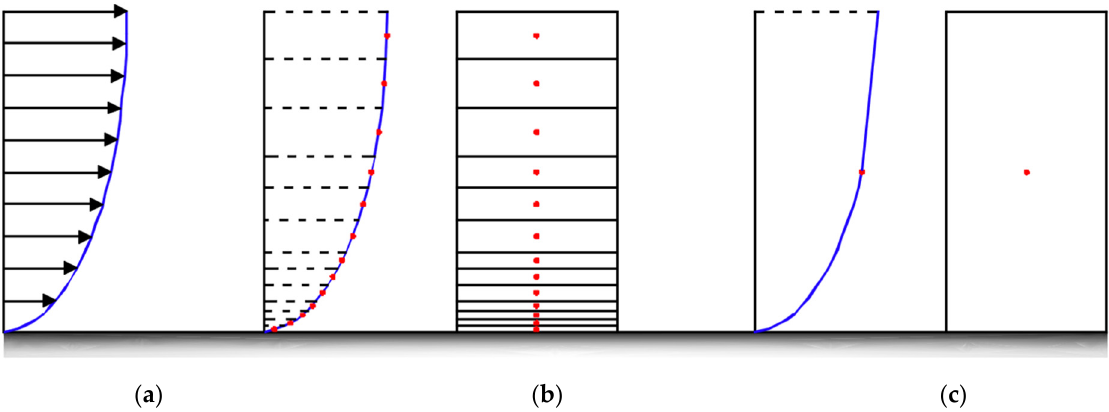
Figure A2. Methods of simulating wind flow velocity in the near-wall region ( a ) The typical vertical wind velocity profile with high velocity gradients close to the wall, ( b ) Standard linear method, and ( c ) Wall function approach.